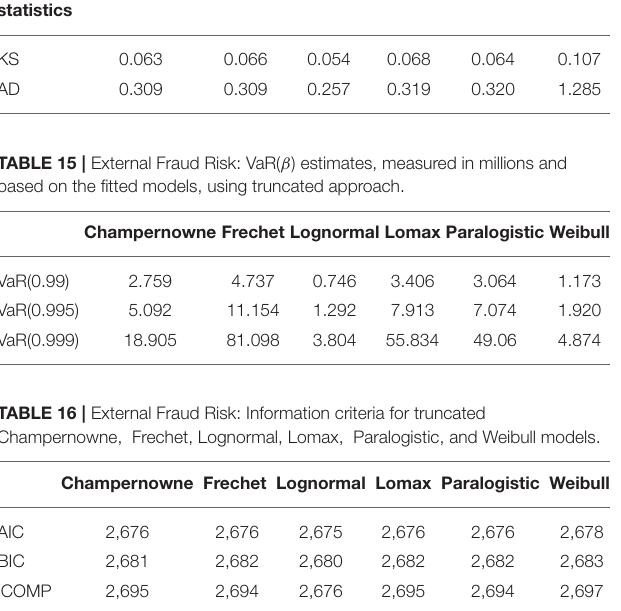
TABLE 14 | The KS and AD statistics for the fitted models, using truncated approach.